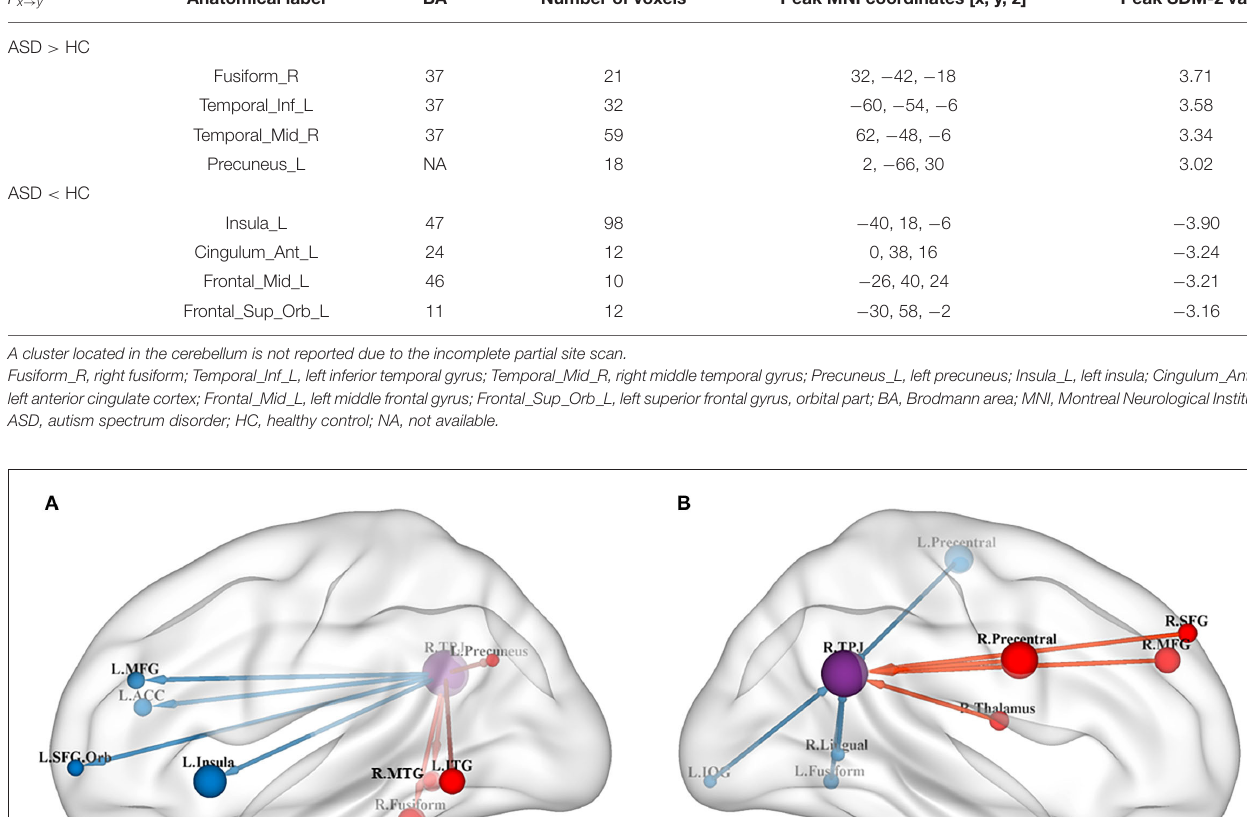
TABLE 2 | The GCA results from seed to the whole brain. F x → y Anatomical label